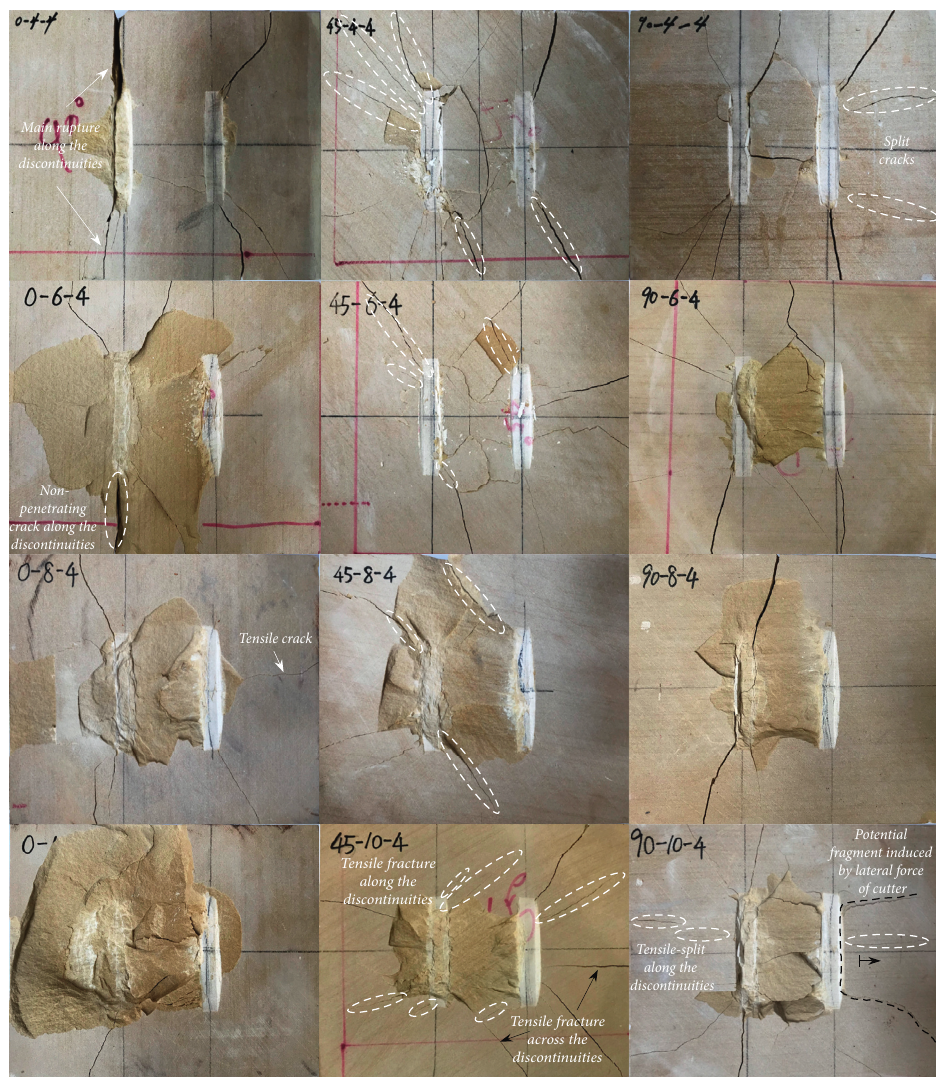
Figure 12: The ultimate failure mode of surface cracks for α � 0 ° , 45 ° , and 90 °